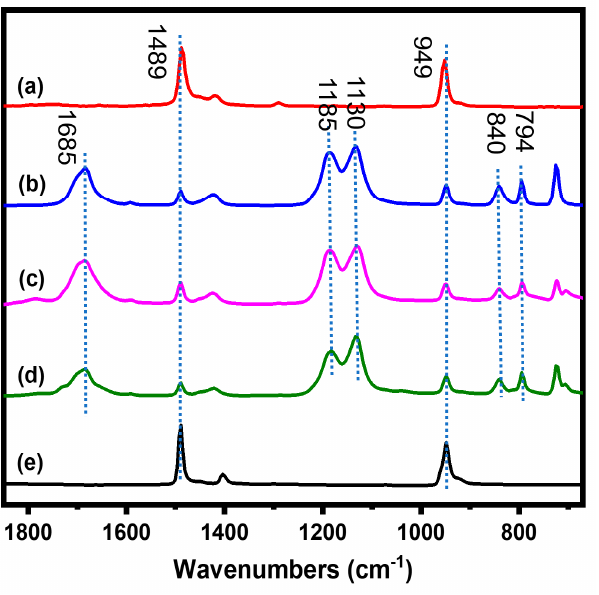
Figure 5. FT − IR analyses spectra of ( a ) [Me 4 N] 2 CoCl 4 , ( b ) isolated solid from [Me 4 N] 2 CoCl 4 -catalyzed reaction, ( c ) synthesized [Me 4 N] 2 CoTFA 4 from [Me 4 N] 2 CoCl 4 and AgTFA, and ( d ) pink solid isolated from [Me 4 N] 2 CoCl 4 dissolved in HTFA and ( e ) Me 4 NCl.